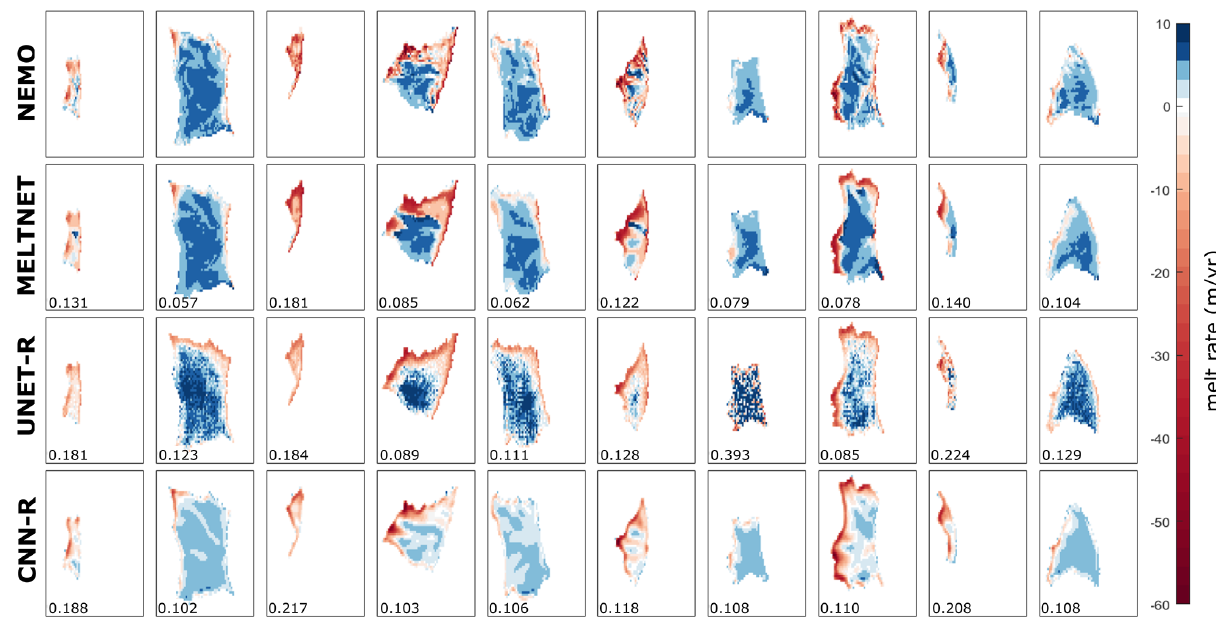
Figure E1. Comparison between a random selection of NEMO-modelled melt rates (row 1), melt rates as predicted by MELTNET (row 2), melt rates predicted by an alternative UNET architecture with a regression output layer (UNET-R; row 3), and a regression CNN (CNN-R; row 4), as described in Sect. E. Numbers in the lower left corner of each neural network output show the NRMSE with respect to the NEMO melt